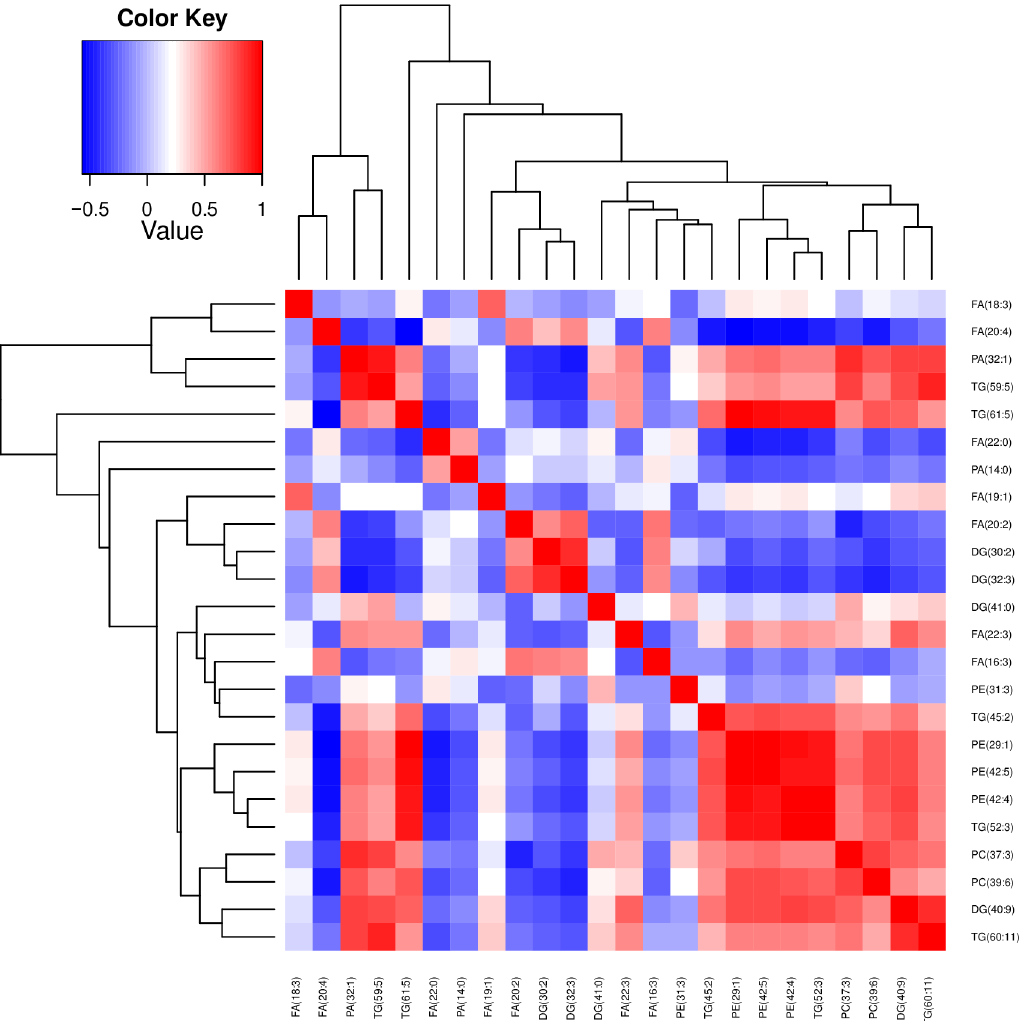
Fig 6. Heat map with pair-wise correlation calculation between entities (differential lipids identified from the current